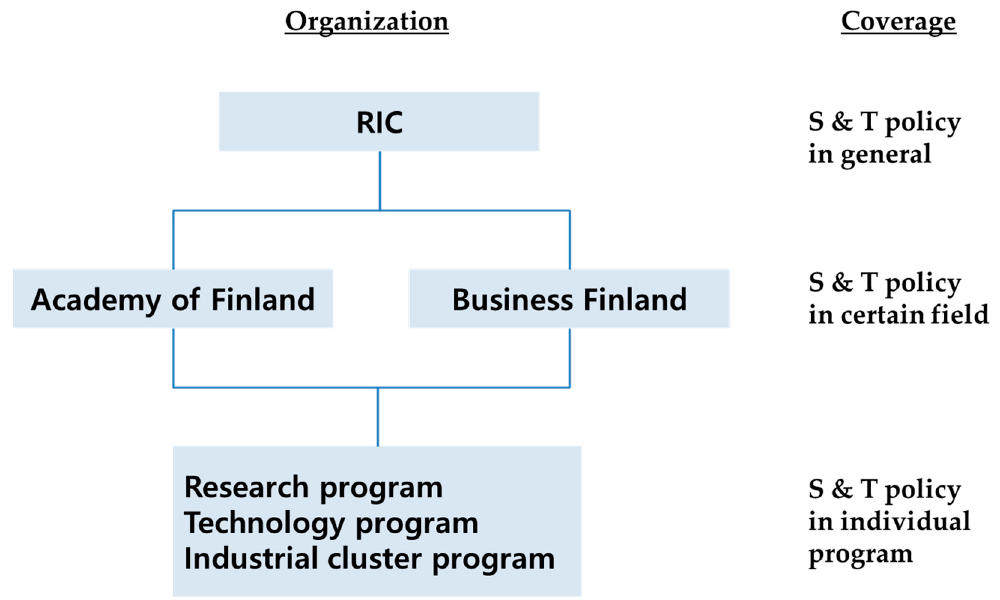
Figure 6. S&T policy deliberation system in Finland.